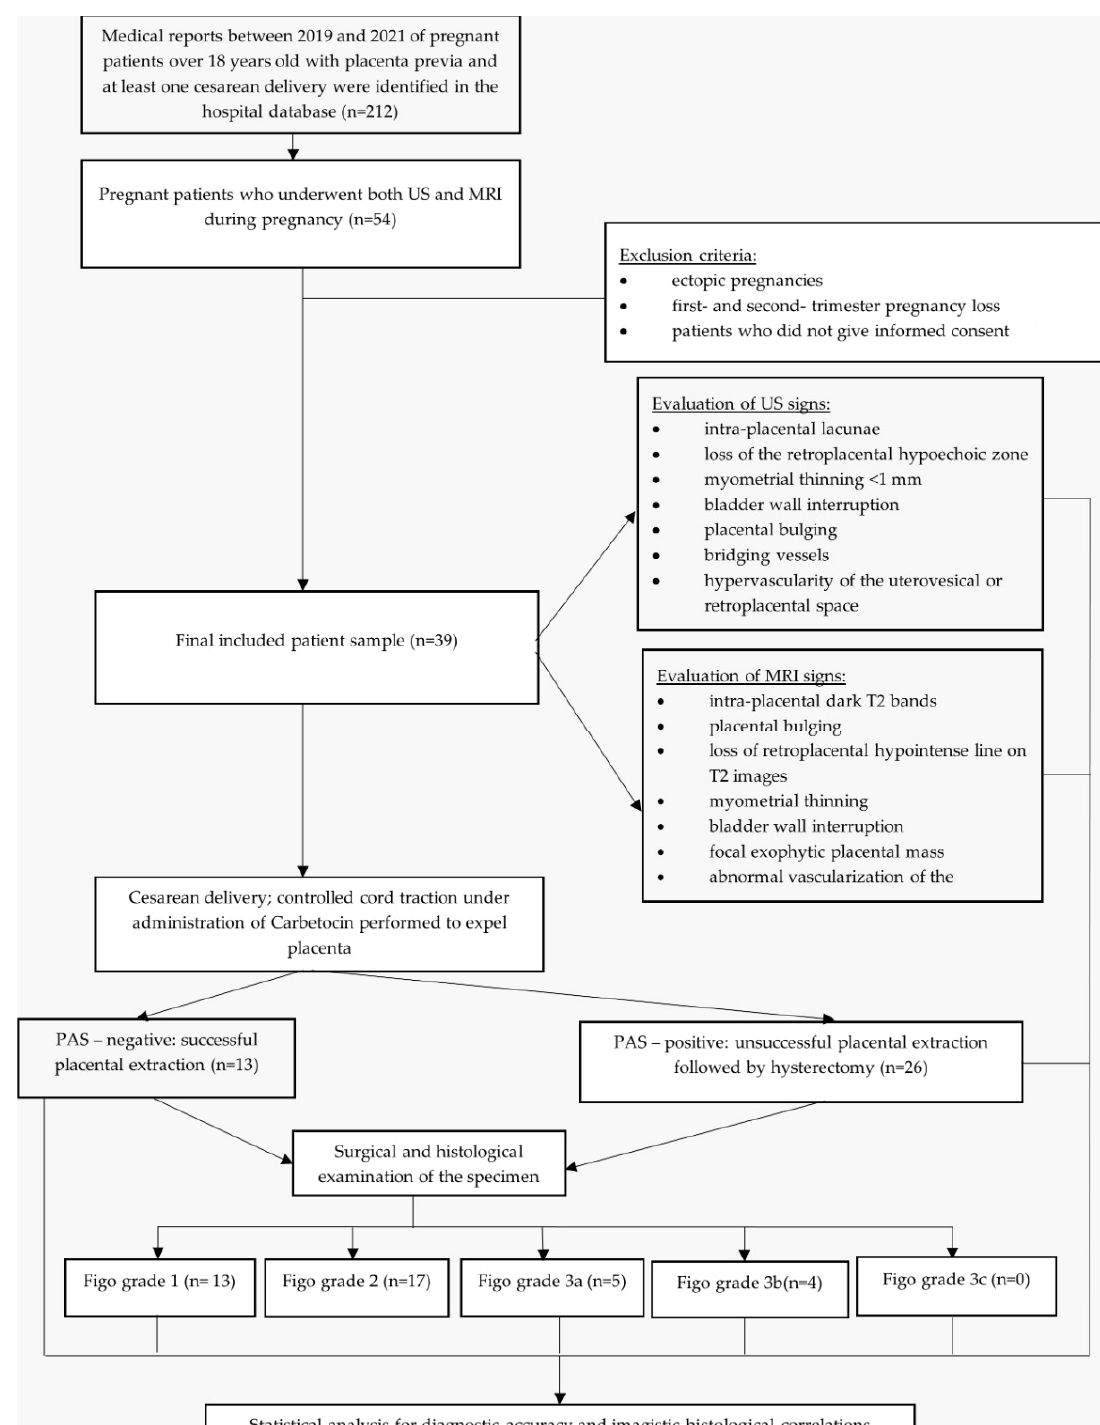
Figure 1. Flow chart of the study design.